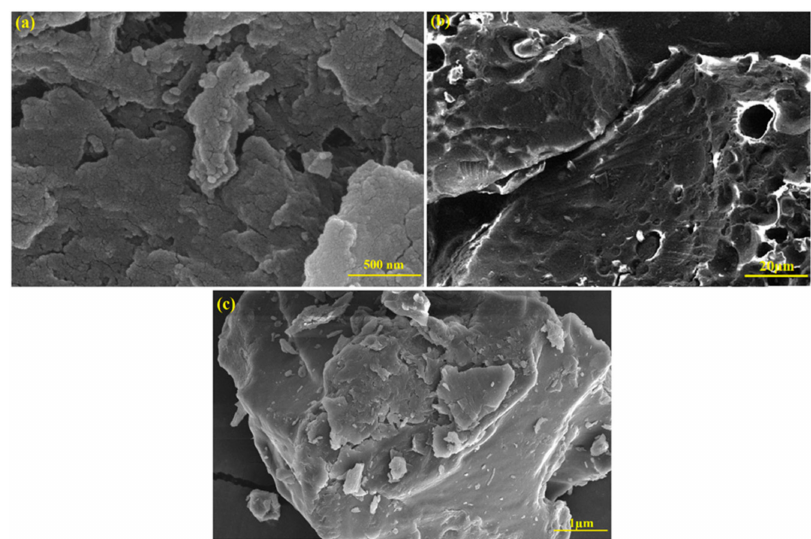
Figure 4. Scanning electron microscope images of ( a ) RGO, ( b ) gum tragacanth-cl- N,N - dimethylacrylamide hydrogel and ( c ) reduced graphene oxide incorporated gum tragacanth-cl- N,N -dimethylacrylamide hydrogel composite.